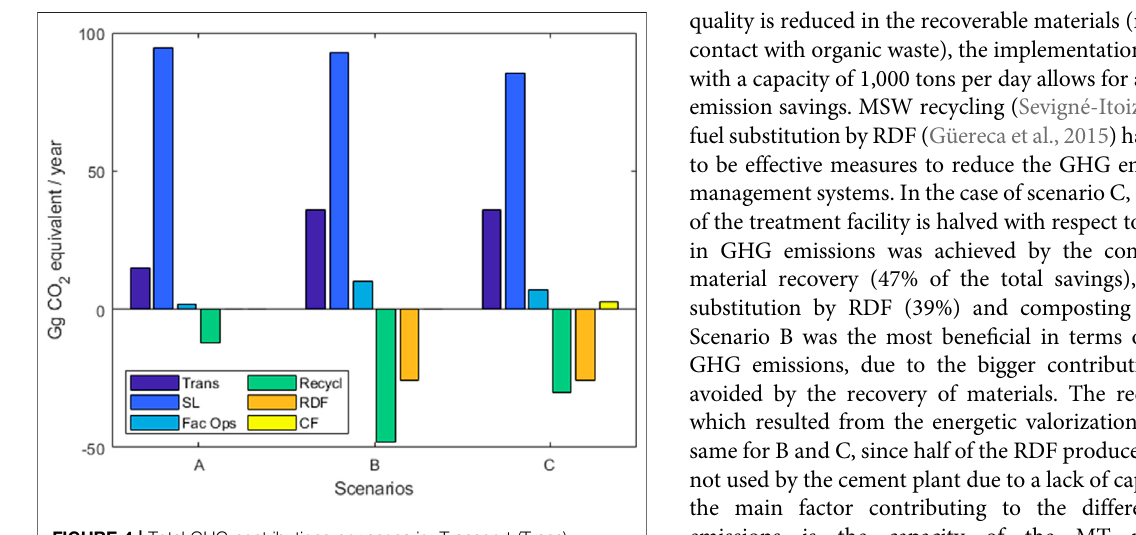
Frontiers in Environmental Science |